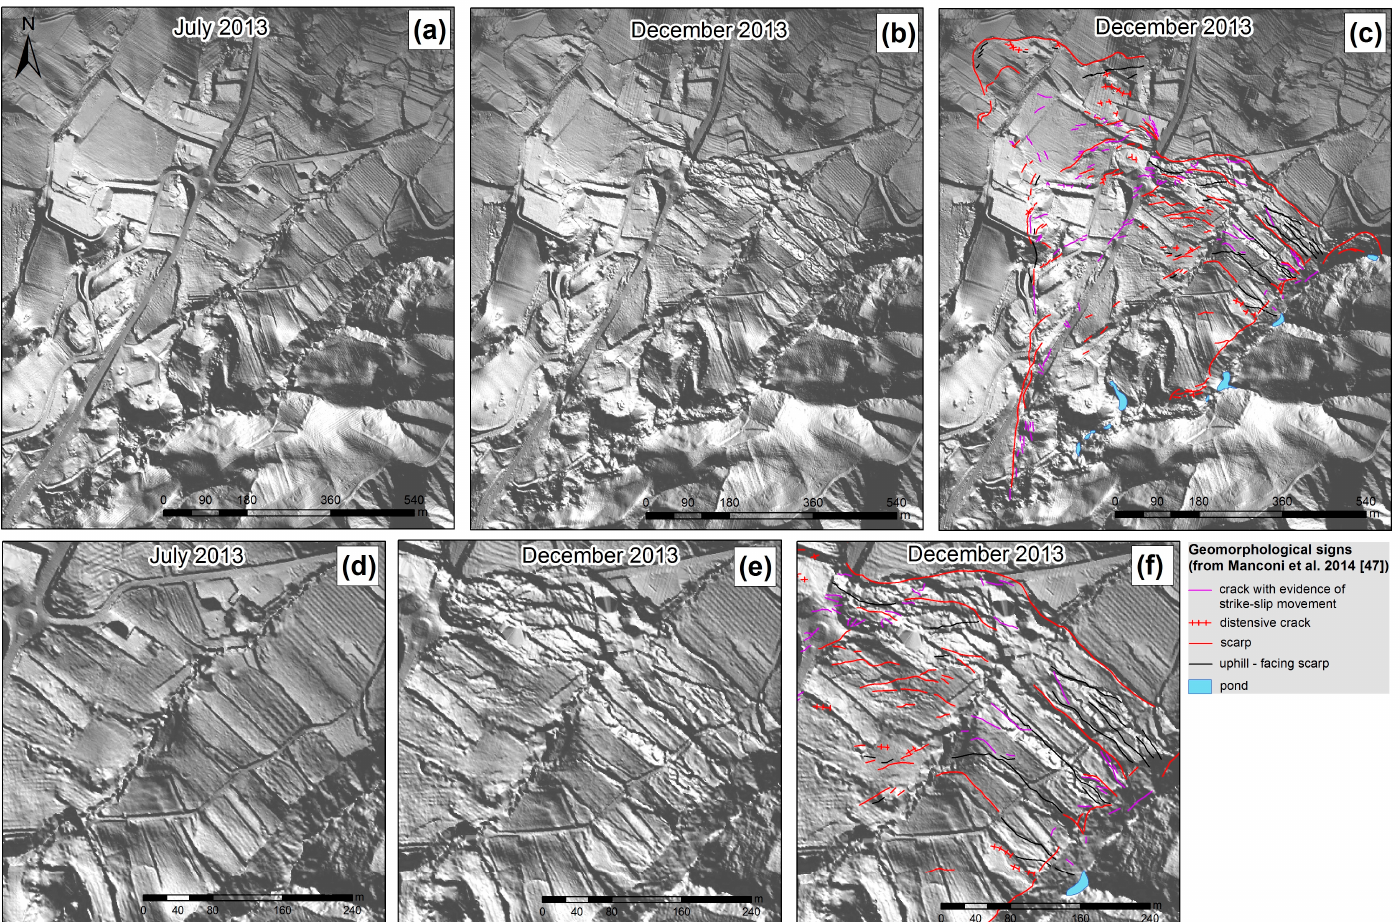
Figure 4. High-resolution LiDAR DTMs: ( a ) DTM produced pre-event in July 2013 (jul2013DTM), ( b ) DTM realized post-event in December 2013 (dec2013DTM), ( c ) dec2013DTM overlapped with the morphological features extracted from the geomorphological map produced by CNR-IRPI [47]; a detail of eastern side of the landslide body, for highlighting the discrepancies between signs from geomorphological map and visible signs from LiDAR survey: ( d ) jul2013DTM, ( e ) dec2013DTM, ( f ) dec2013DTM overlapped with the geomorphological